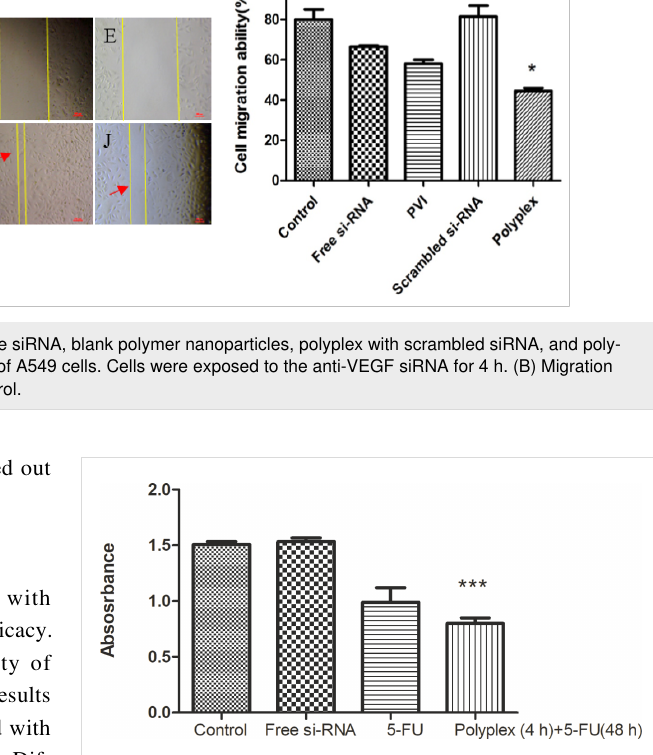
Figure 12: Viability of A549 cells after silencing VEGF using free siRNA or the polyplex for 4 h followed by treatment with 5-FU for 48 h. A final concentration of 100 nM siRNA and 400 µM of 5-FU were used in A549 cells and shown as mean ± SD ( n = 3). *** p < 0.05 compared with the